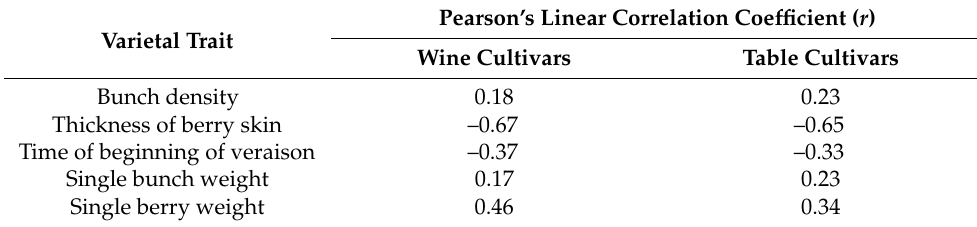
Table 6. Correlation between severity of bunch sour rot and selected varietal traits.